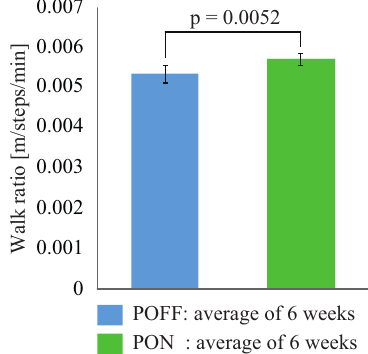
Figure 9. Comparison of the average walk ratio of each week between the POFF condition and the PON condition.